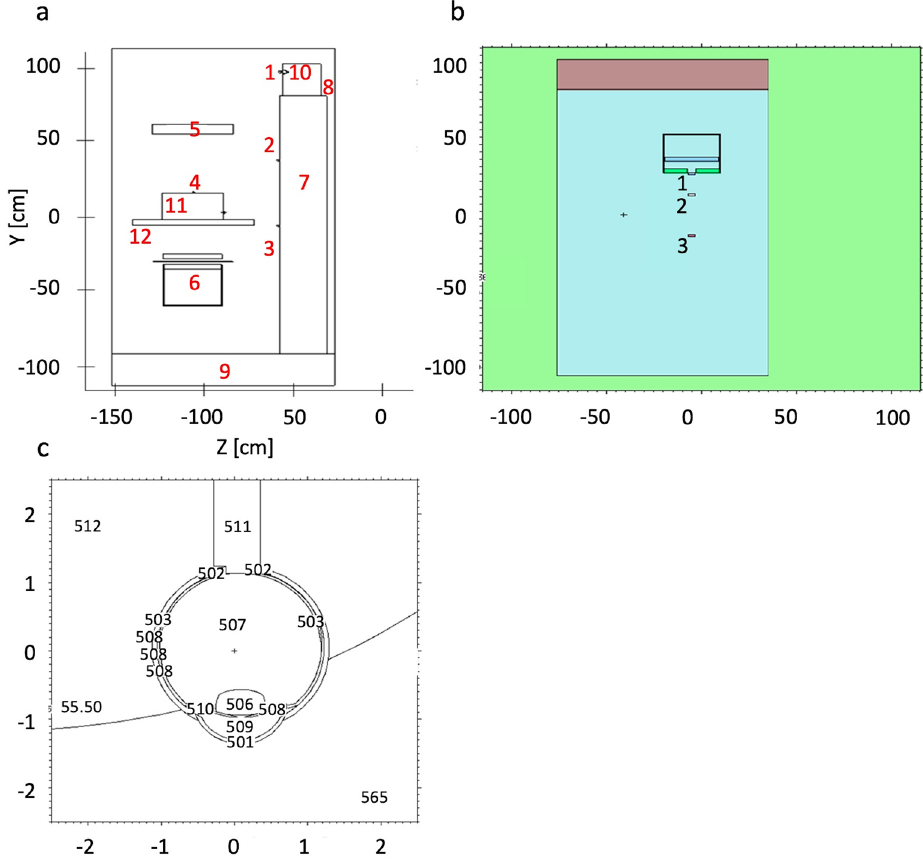
Figure 2. ( a ) Scenario A. MCNP geometry. Left, X-ray exposure setup in Z-Y view; 1, detector simulating the Petri dish at the eye lens level; 2, detector simulating the Petri dish at the chest level; 3, detector for the spectra estimation at the gonads level; 4, detector simulating the Petri dish in the attenuated primary beam; 5, X-ray detector; 6, X-ray system; 7, water phantom simulating the operator body; 8, water phantom simulating the operator head; 9, concrete floor; 10, operator eye (see right part of this figure for details); 11, PMMA phantom; 12, patient couch. ( b ) Scenario B. MCNP geometry visualization. Background color representative of the zero- importance region outside the “simulation box”. The visualized MCNP cells related to the concrete, the X-ray tube model, the Monte Carlo detector and the 2 Petri dishes are shown. Different colors for distinguishing the different MCNP cells. Tally regions 2(B) and 3(B) related to the Petri dish positions. Tally region 1(B) referred to a numerical detector. ( c ) Operator eye in X–Y view as plotted by the MCNP intrinsic viewer. 501, Cornea; 502, Sclera; 503, Retina; 506, Eye lens; 507, Vitreous body; 508, Choroid; 509, Anterior chamber 510, Iris; 511, Optic nerve. Eye model volume, 7.89 cm 3 ; Axial length, 2.58 cm; Lens Volume, 0.163 cm 3 ; Equatorial length, 0.410 cm; Lens depth, 0.390 cm.